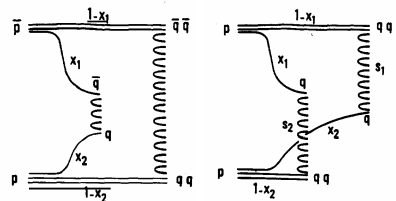
Figure 3: Hadron chains form to keep the final state a colour singlet. (Figure bor- rowed from [ 8 ] )